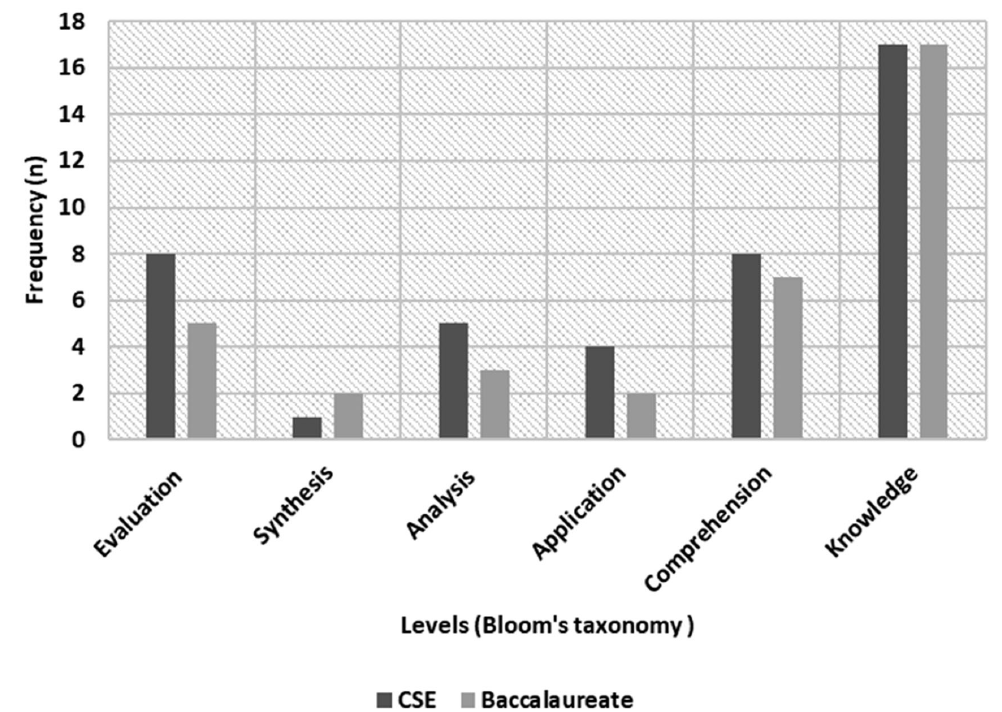
Figure 1. Cognitive demand for compulsory secondary education and baccalaureate.